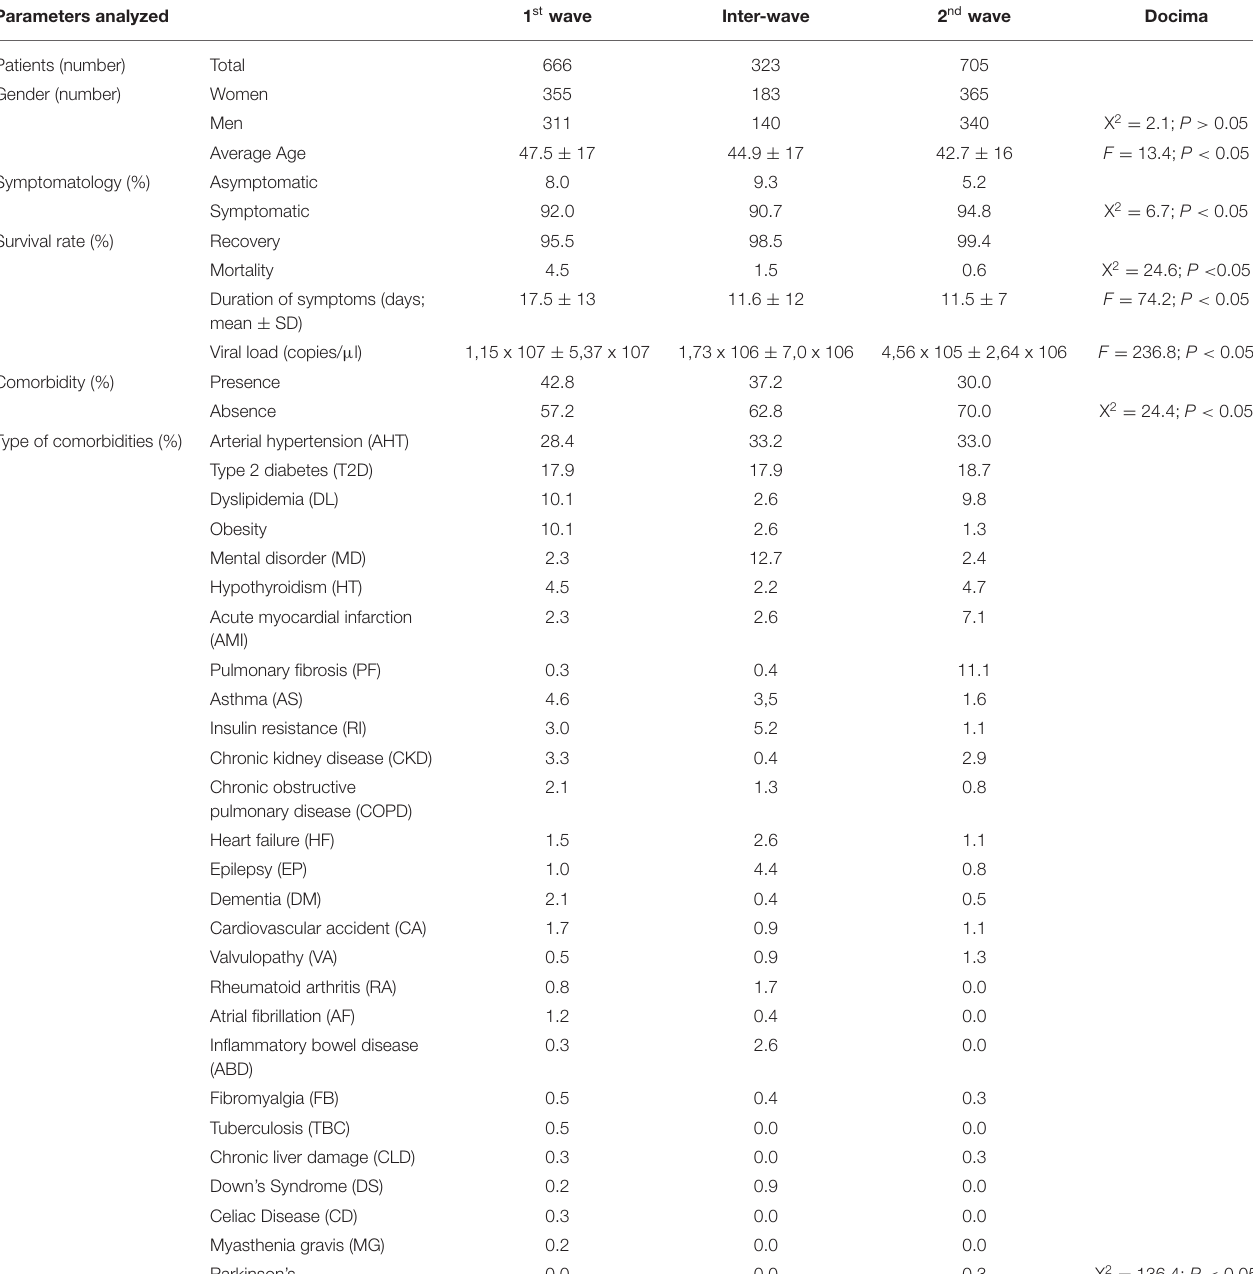
TABLE 1 | Clinical and epidemiological characteristics of patients with COVID-19 infection from Chuchunco health center. Parameters analyzed 1 st wave Docima Patients